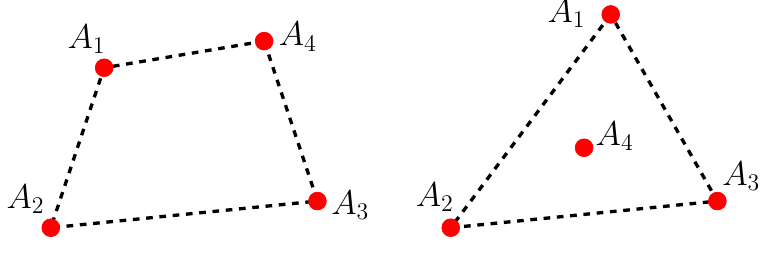
Figure 4. Possibilities for the convex hull of the four airports involved in two routes.